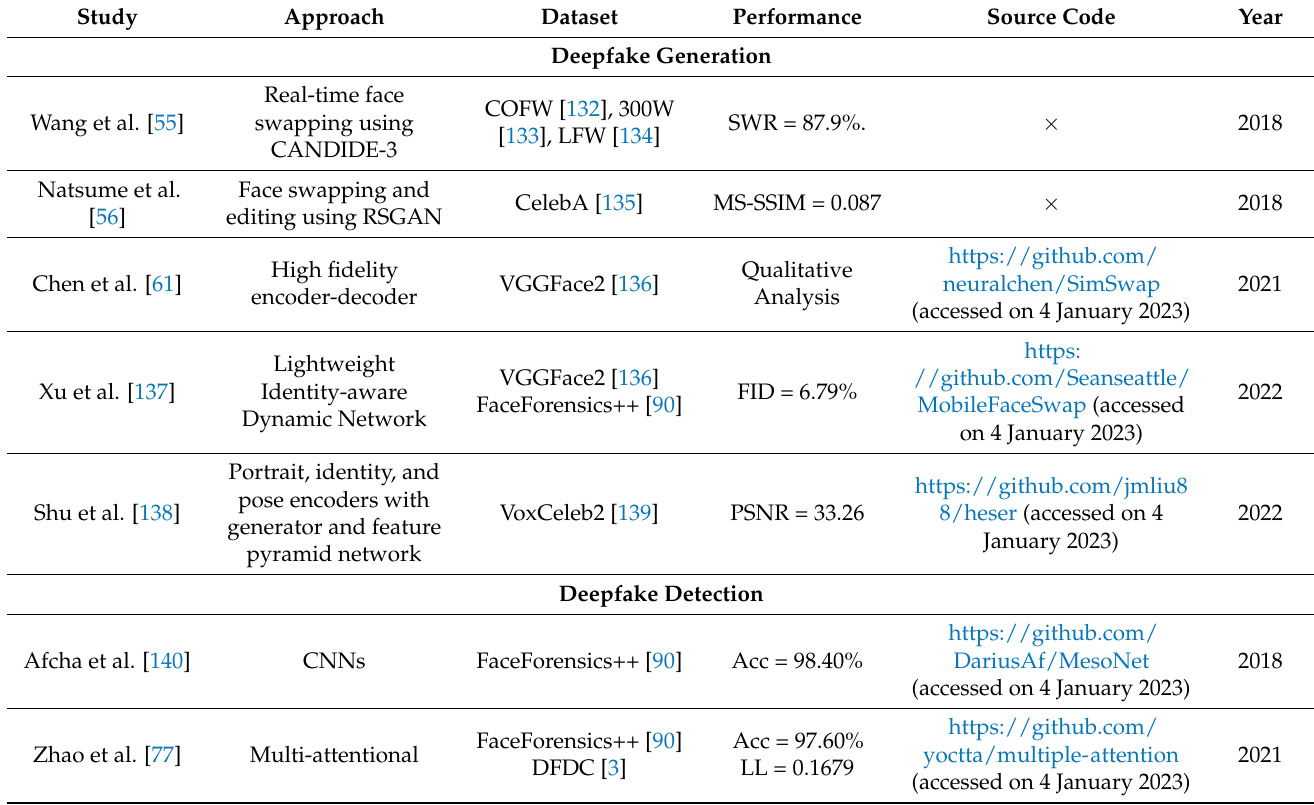
Table 1. Representative works on deepfake and face manipulation generation and detection tech- niques. SWR = successful swap rate; MS-SSIM = multi-scale structural similarity; Acc = accuracy; LL = Logloss; AUC = area under the curve; CL = contextual loss; RMSE = root mean square error; AU = Facial action unit; CSIM = Cosine Similarity between IMage embeddings; EER = Equal error rate; FID = Frechet inception distance; AP = Average Precision; KID = kernel inception distance; PSNR = Peak Signal-to-Noise